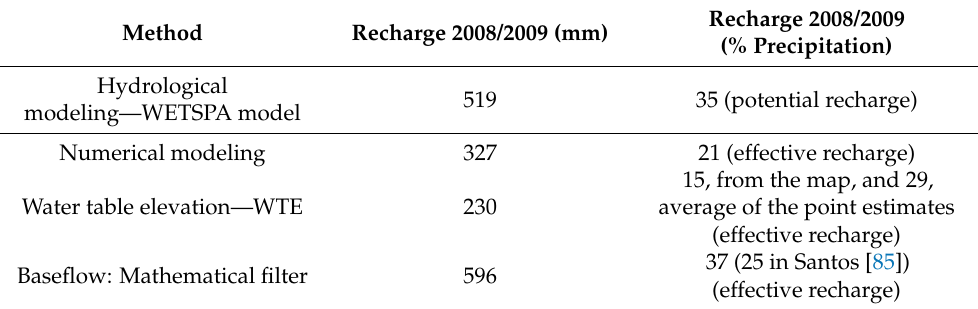
Table 7. Recharge rates for the hydrological year 2008/2009 in the Cap ã o Comprido watershed. Method Recharge 2008/2009 (mm)